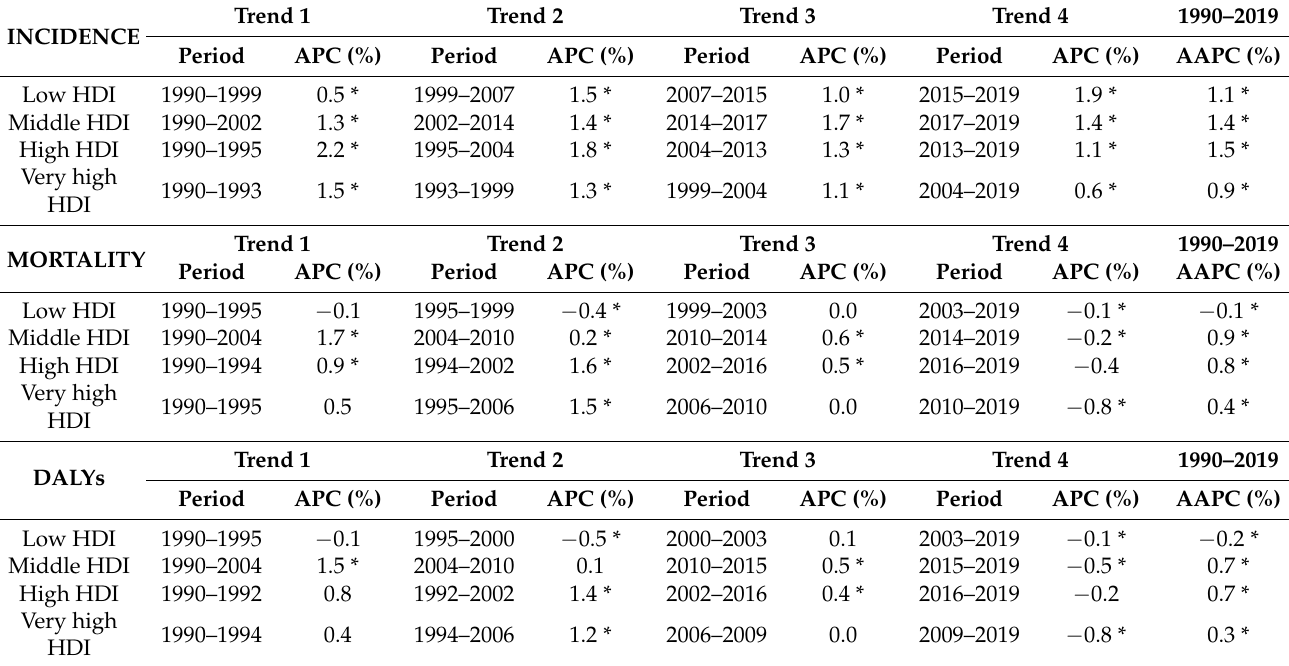
Table 1. Age-standardized CKD incidence, mortality, and DALYs rates in 1990, 2019, and joinpoint trend analysis between 1990 and 2019 by HDI settings.